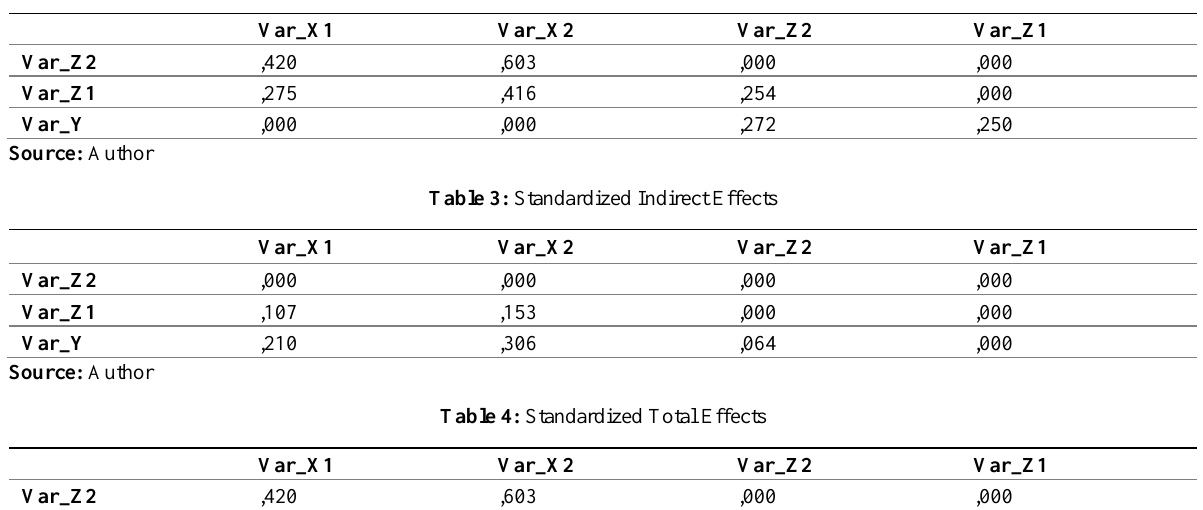
Table 2: Standardized Direct Effects